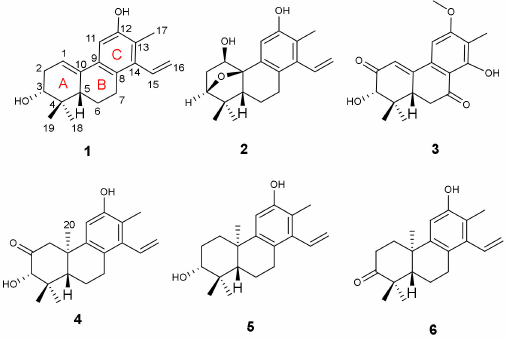
Figure 1. The structures of compounds 1 – 6